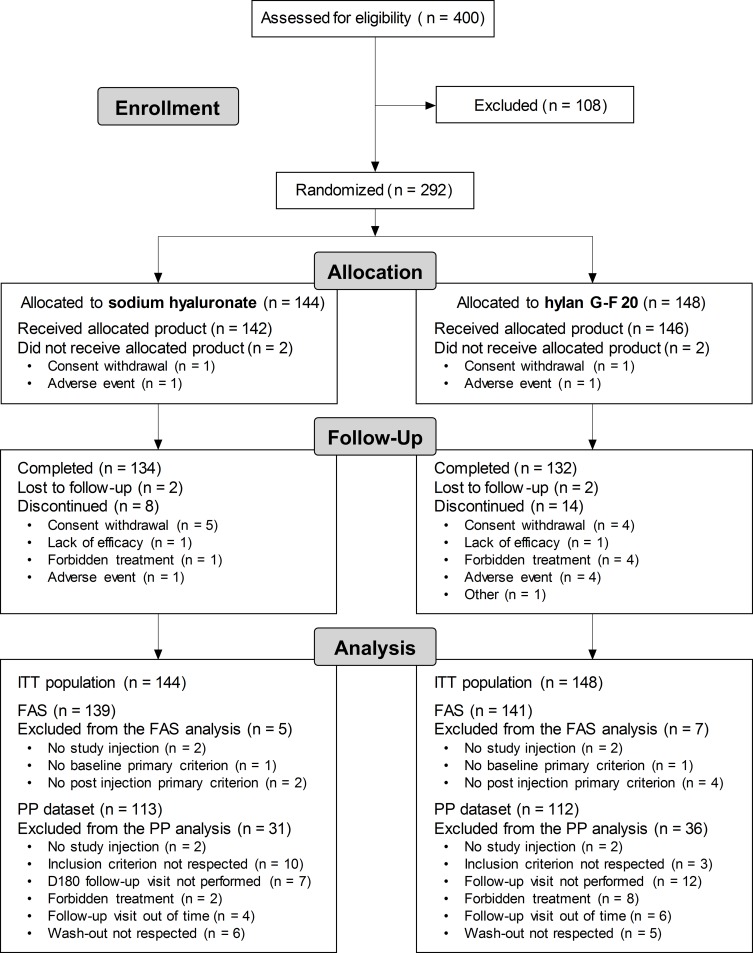
CONSORT flow diagram.FAS = Full Analysis Set; ITT = Intention-to-Treat; n = number of patients; PP = Per Protocol.